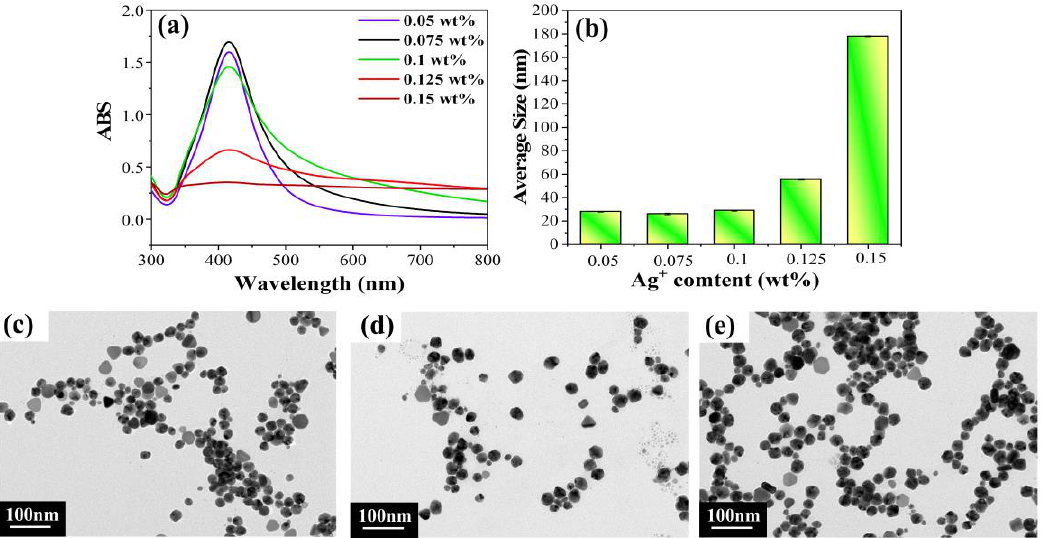
Figure 4. Results for different Ag + contents: ( a ) UV-vis spectra; ( b ) average size histogram; ( c – e ) TEM images for Ag + contents of 0.05 wt%–0.1 wt%, respectively.